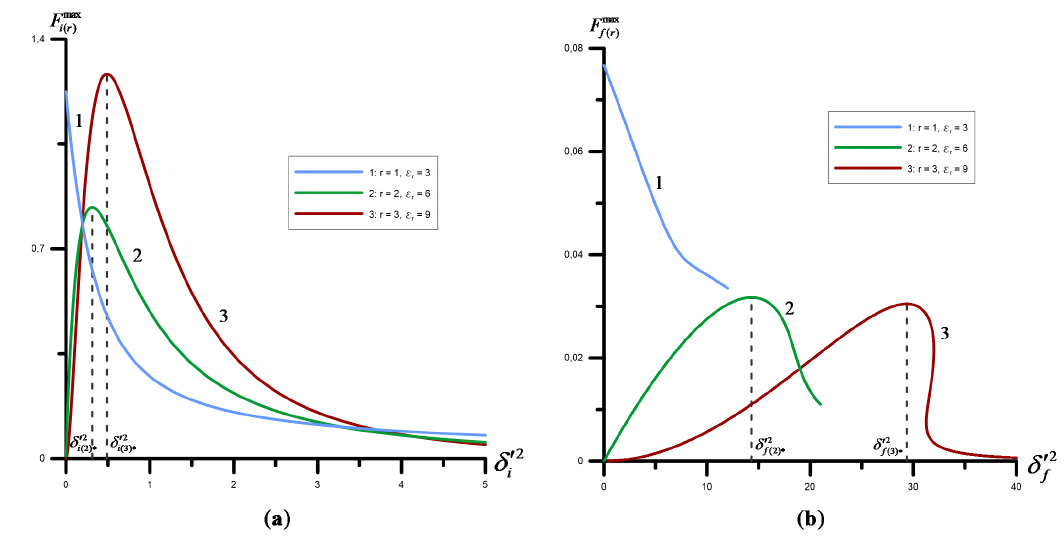
Figure 6. ( a ) Dependency of F max F max (99) function on parameter δ (cid:48) 2 f ( r ) characteristic parameter— ε 1 = 3, the characteristic energy— E 1 = 100 MeV, the energy of the initial electron— E i = 300